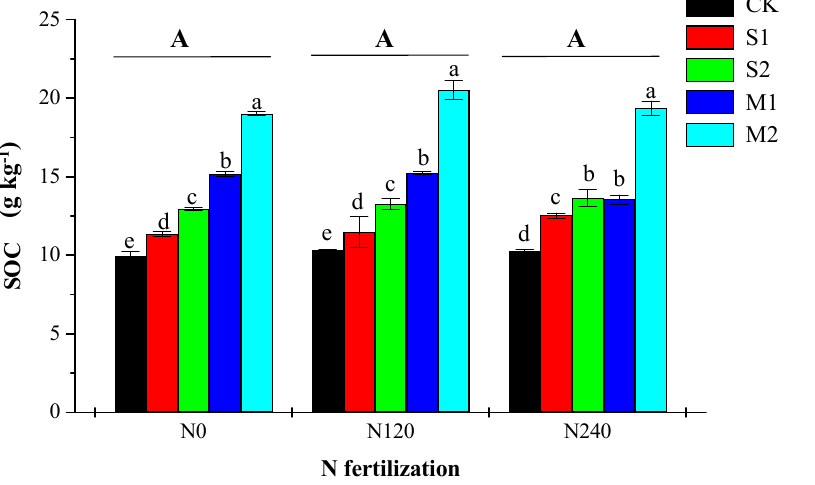
Figure 1. Soil organic carbon (SOC) concentrations under various carbon (C) and nitrogen (N) management treatments. N fertilizer was applied for 17 years with urea (N0 = control with no N fer- tilization; N120 = N fertilization at 120 kg ha − 1 year − 1 ; N240 = N fertilization at 240 kg ha − 1 year − 1 ). Organic amendments were applied for 3 years with wheat straw or sheep manure (CK = con- trol with no organic amendment; S1 = straw return at 7500 kg ha − 1 year − 1 ; S2 = straw return at 15,000 kg ha − 1 year − 1 ; M1 = manure addition at 30,000 kg ha − 1 year − 1 ; M2 = manure addi- tion at 45,000 kg ha − 1 year − 1 ). Different lowercase letters indicate significant differences among the five organic amendment treatments ( p < 0.05). Different uppercase letters indicate significant differences among the three nitrogen fertilization treatments ( p <